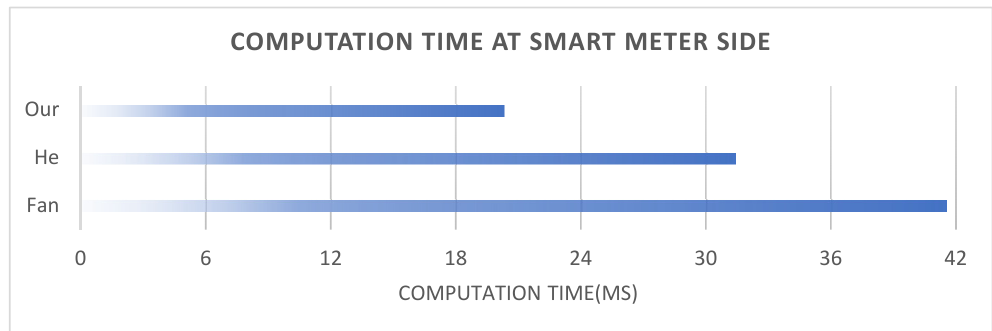
Figure 3. Computation costs at smart meter side in aggregation